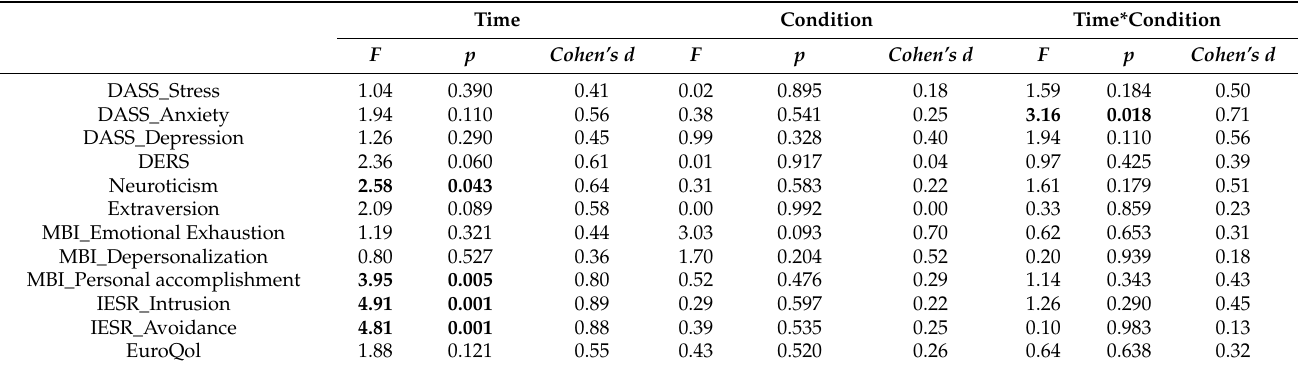
Table 3. Main effects of the linear mixed models.